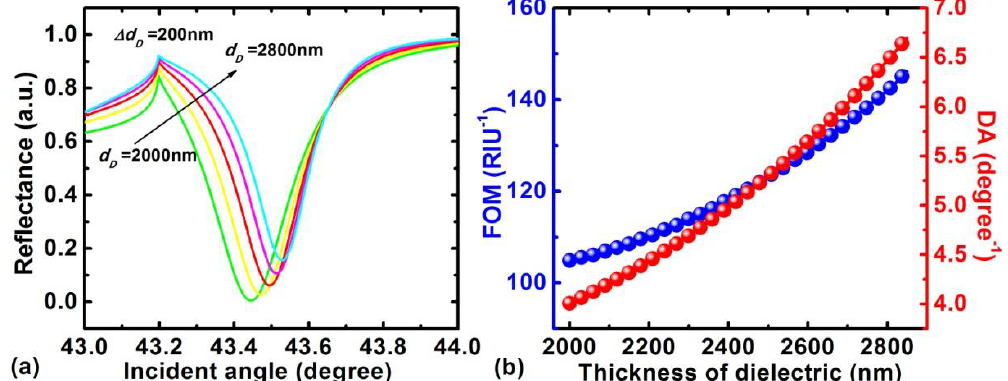
Figure 5. ( a )Variation of the reflectance with the incident angle when the thickness of the dielectric ( d D ) changes from 2000 nm to 2800 nm; ( b ) variation of the FOM and DA with the increase of dielectric thickness.